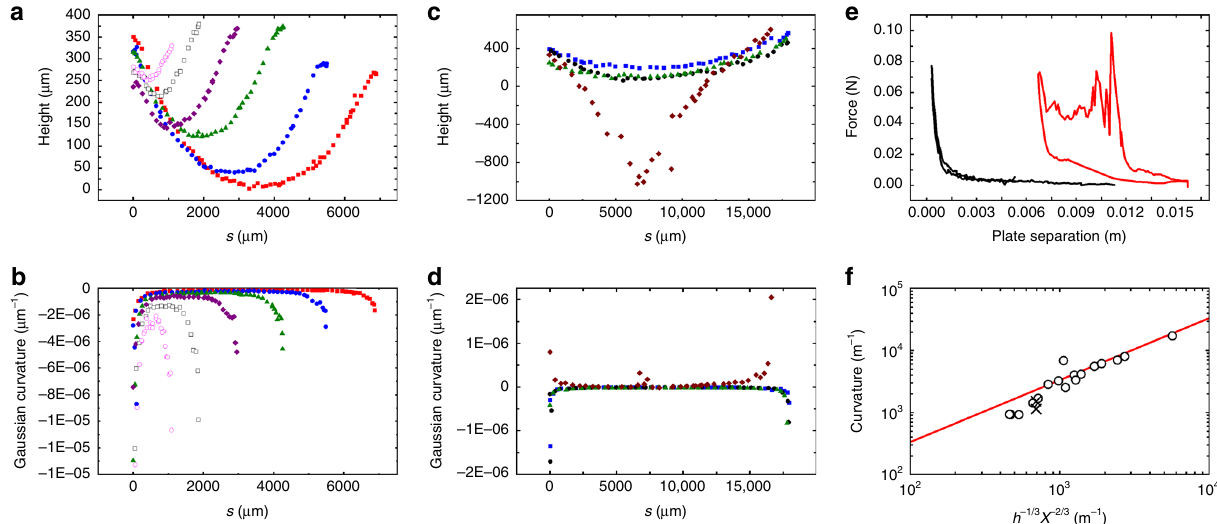
Fig. 6 Geometry of a stretching ridge. a Ridge height of the polydimethylsiloxane (PDMS) sample shown in Fig. 5a – c as a function of s , a coordinate running along the peak curvature of the ridge. All quantities are obtained by fi tting a parabola to the fi lm surface in a section cut orthogonal to s . The fi lm surfaces are observed directly with confocal microscopy. b The Gaussian curvature of the ridge as a function of s . c Height data of the polycarbonate (PC) sample shown in Fig. 5d – f. d Gaussian curvature of the PC fi lm as a function of s . Note that there is little change in curvature until the ridge buckles. e Force displacement data for the PDMS (red) and PC (black) samples. f Curvature at the ridge midpoint vs h (cid:2) 1 = 3 X (cid:2) 2 = 3 . The linear trend shows the agreement between the geometry assumed in ref. 19 and both PC and PDMS